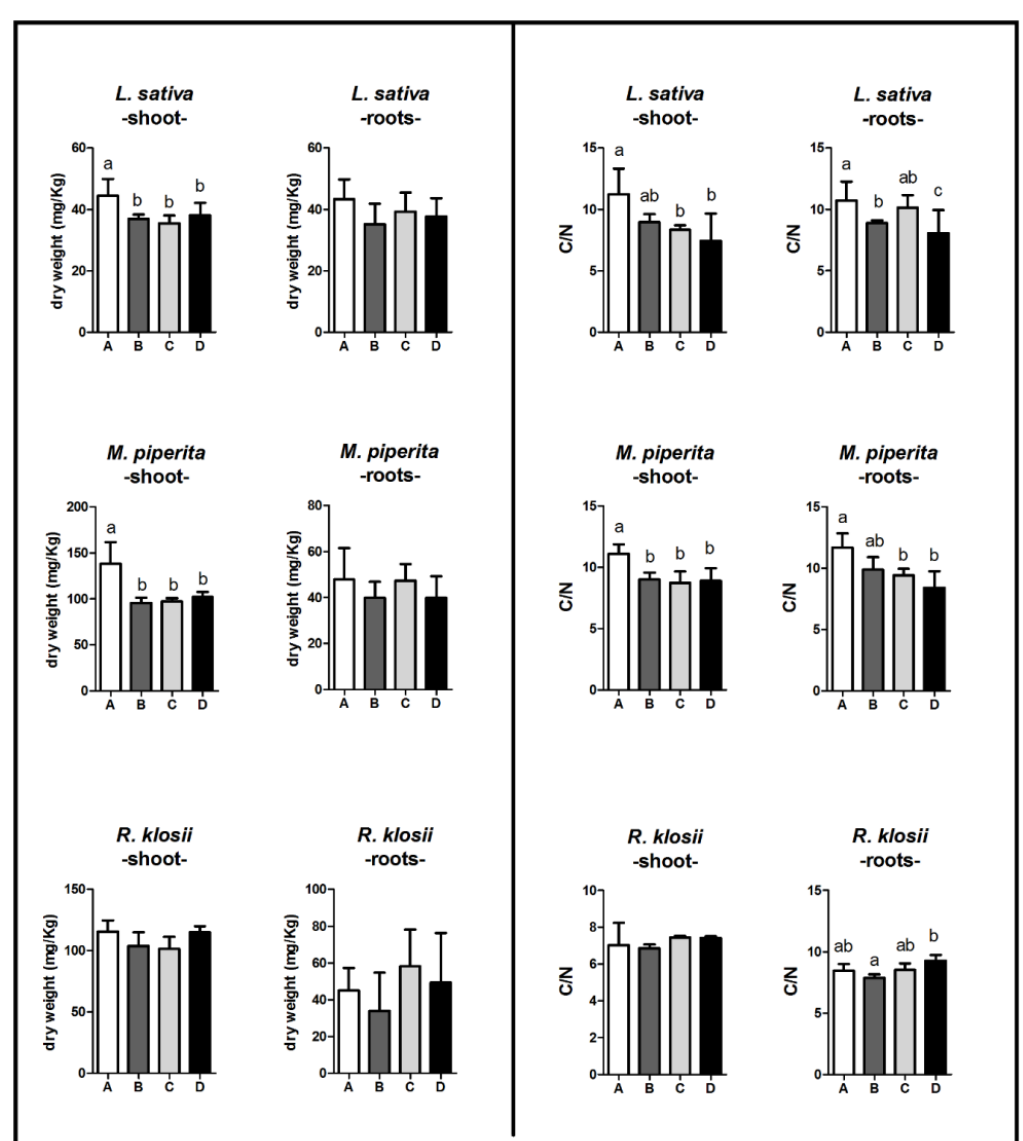
Figure 6. Biomass composition of the lettuce, mint and mushroom herbs in the experimental groups. Values are means ± SD. Different lowercase letters indicate significant differences ( p < 0.05). ( Left ) Dry weight fraction of the total fresh biomass in the shoots and roots ( n = 6). ( Right ): Carbon to nitrogen atomic ratio ( n = 3).